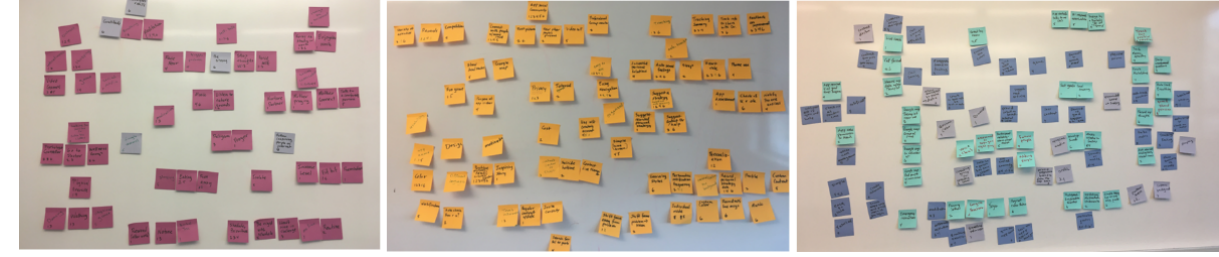
Figure 1. Codes generated from each phase (1, 2, and 3) in order from left to right.